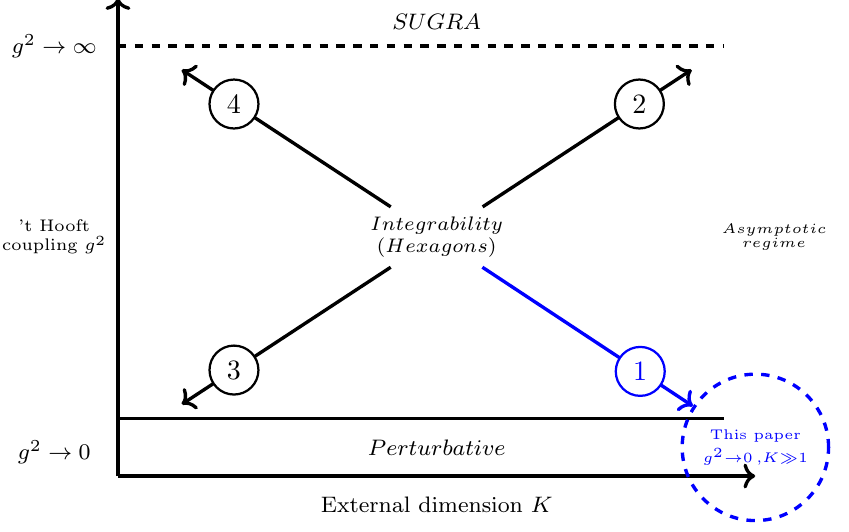
Figure 18 . Regimes for di(cid:11)erent values of the coupling g and the external scaling dimension K